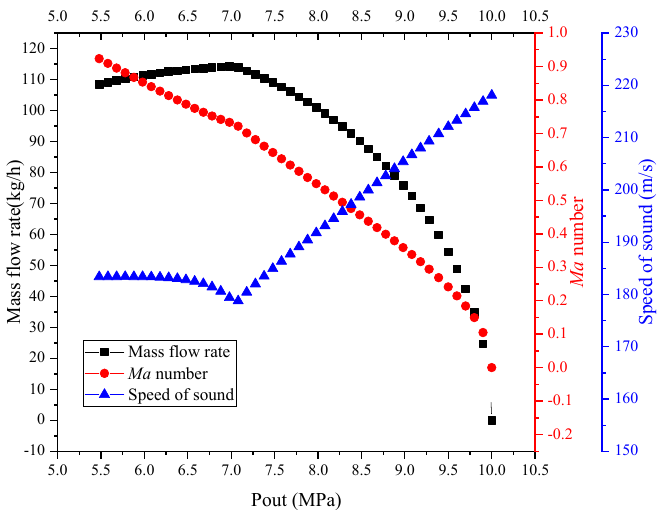
Figure 11. The curve of sealing performance of round hole calculated by 1-D method.